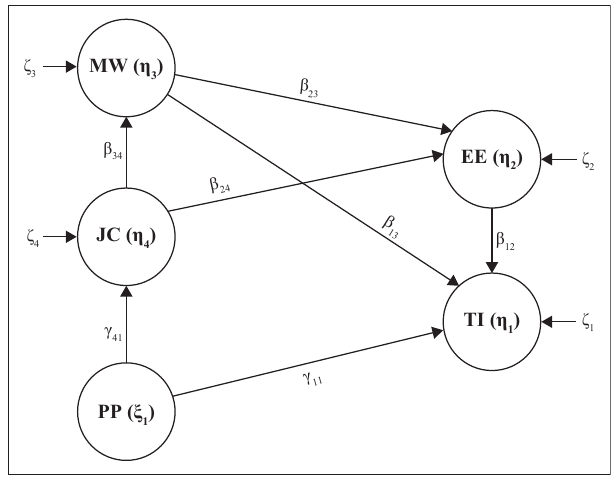
FIGURE 2: Revised employee engagement and turnover intention structural model.